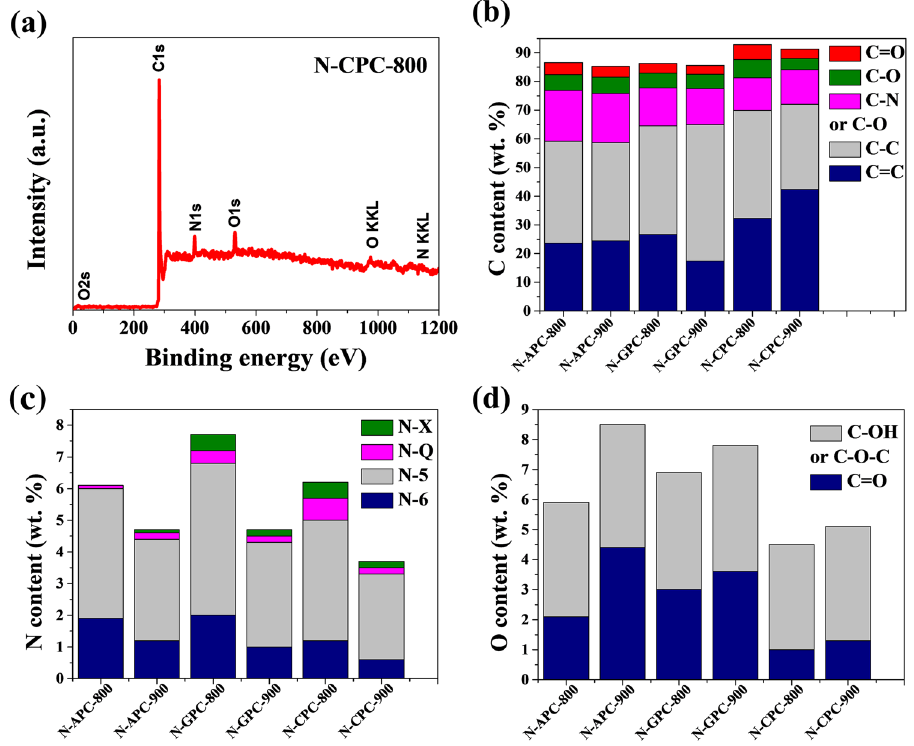
Figure 3. ( a ) XPS survey spectrum taken from the surface of N-CPC-800 sample. Content percentages of different ( b ) carbon species, ( c ) nitrogen species, ( d ) oxygen